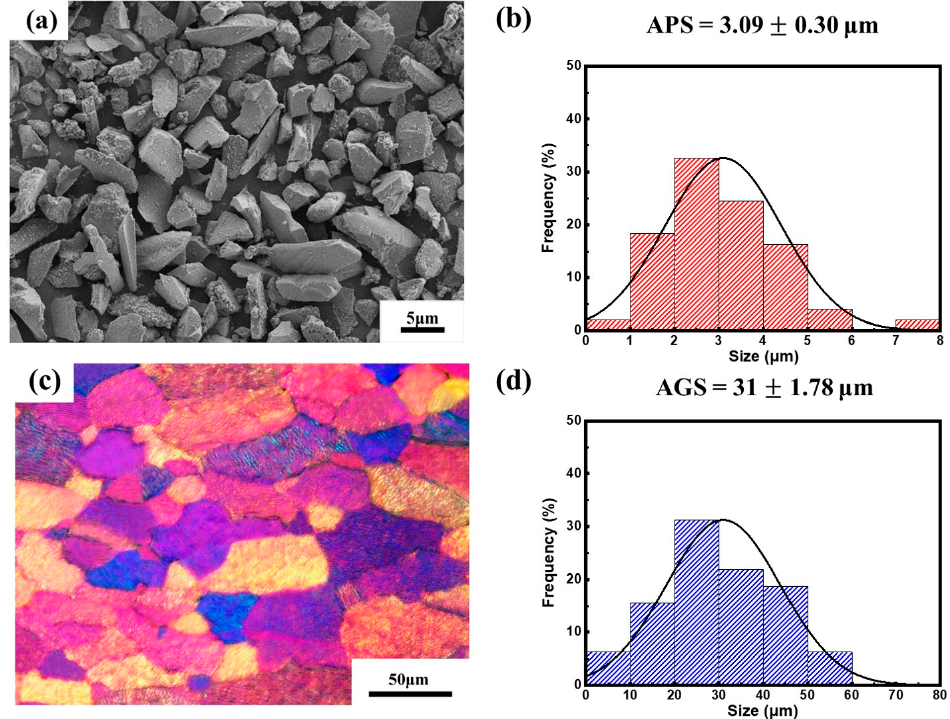
Figure 1. ( a ) SEM image of micron-sized SiC particles; ( b ) APS distribution of SiC particles; ( c ) optical micrograph of annealed 1050 Al; ( d ) AGS distribution of annealed 1050 Al.